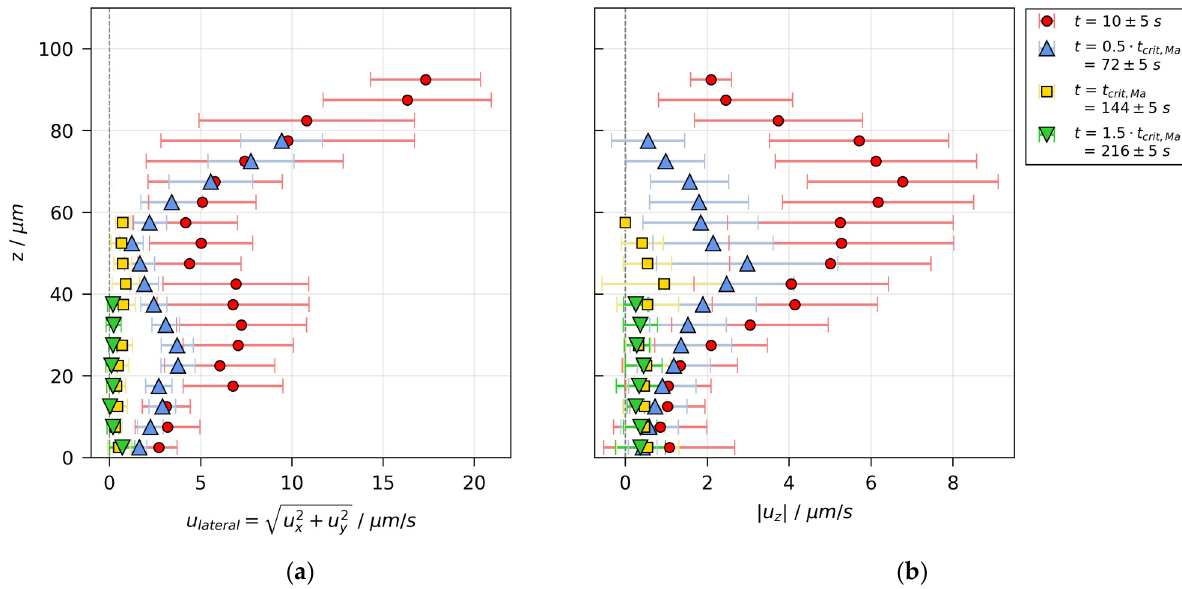
Figure 7. Velocity distribution in a poly(vinyl acetate)-methanol film ( X 0 = 1.5 g MeOH / g PVAc and h gap = 200 µ m ), drying at T substrate = 20 ◦ C and otherwise ambient conditions, measured with 3D- µ PTV and evaluated with mean refractive index. Data are averaged laterally and in vertical slices of ∆ z = 5 µ m. The flow field shows convective instabilities until t crit , Ma = 144 s. ( a ) Lateral velocity over film height. ( b ) Absolute vertical velocity over film